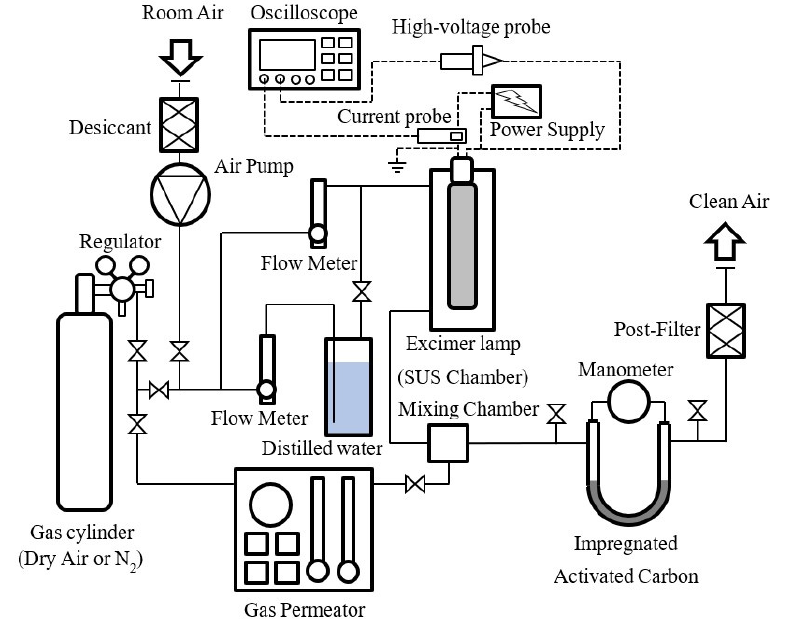
Figure 2. The schematic image of the experimental setup for characterization of the excimer